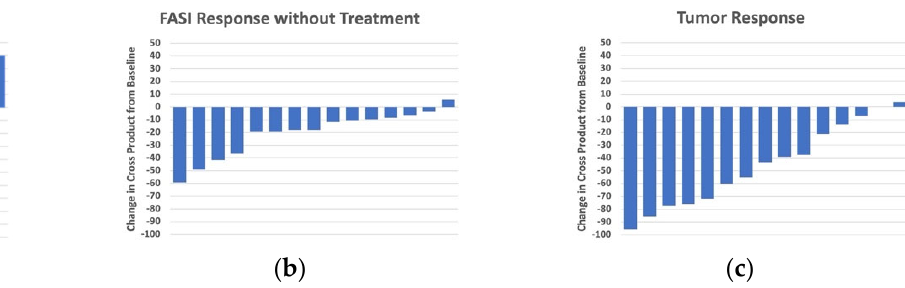
Figure 1. Spider plots demonstrating the percent change in the cross product of lesions from the baseline. Change in FASI from the chosen anatomic locations are shown on treatment with selumetinib ( a ) and without treatment ( b ) with variable responses. Treatment of LGG with selumetinib showed a consistent decrease over time ( c ).